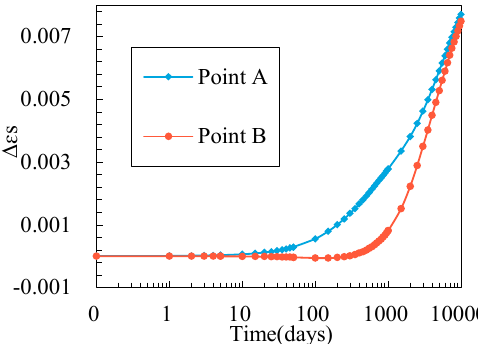
Figure 11. Evolution of the coal matrix strain induced by adsorption/desorption of gas at Point A and